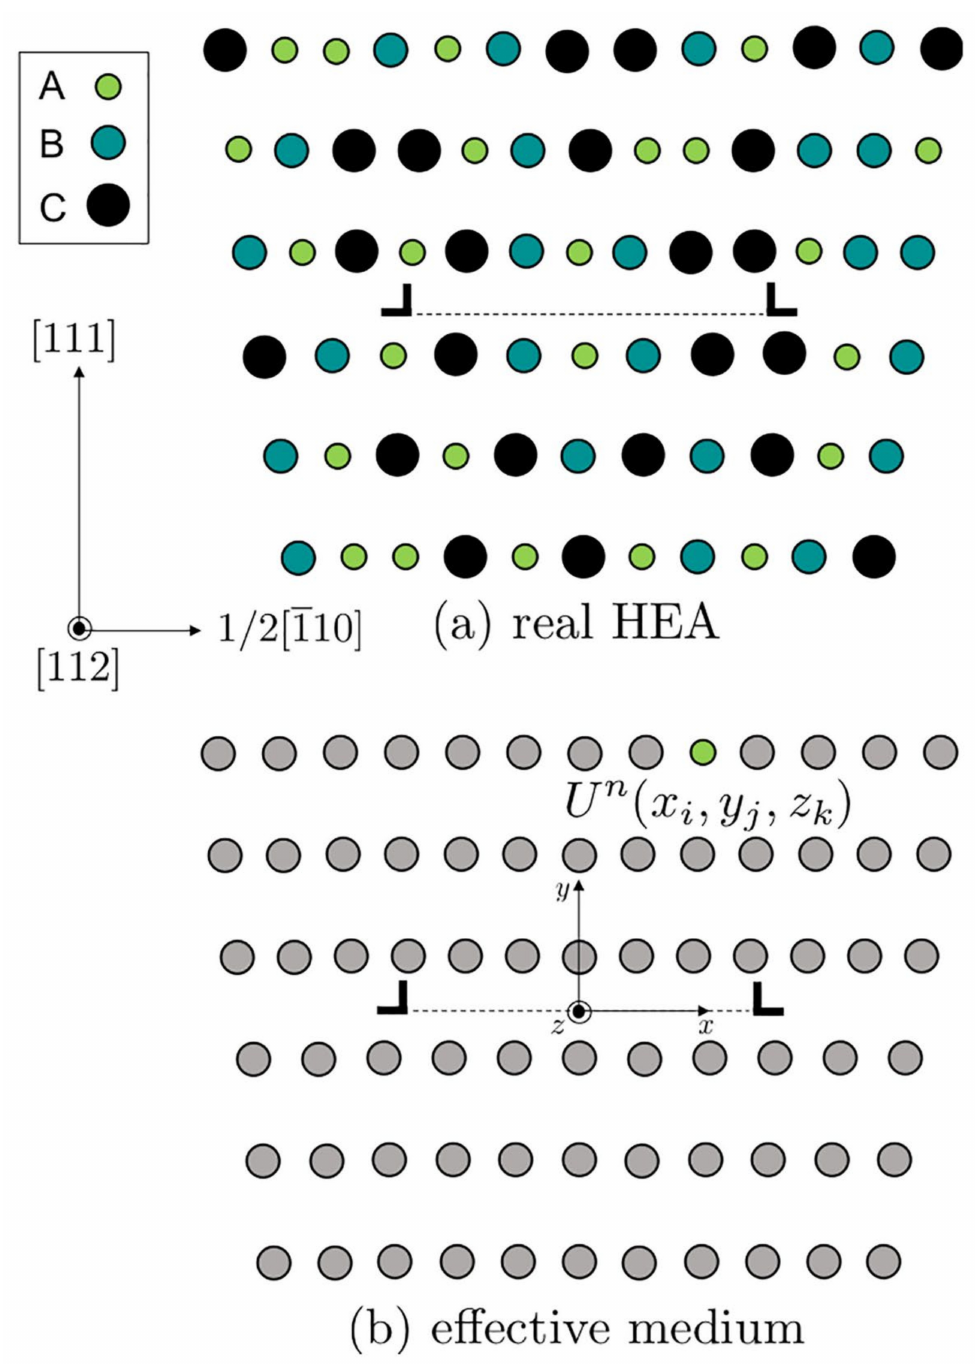
Figure 2. Schematic showing effective medium approach for dislocation/solute interactions. ( a ), Fully-random 3-component (A,B & C) HEA containing a dissociated edge dislocation; ( b ), Effective matrix material of the same alloy, with an embedded A “solute” at position (xi, yj, zk) relative to the dislocation centered at the origin, with interaction energy UA (xi, yj, zk). Adapted from: